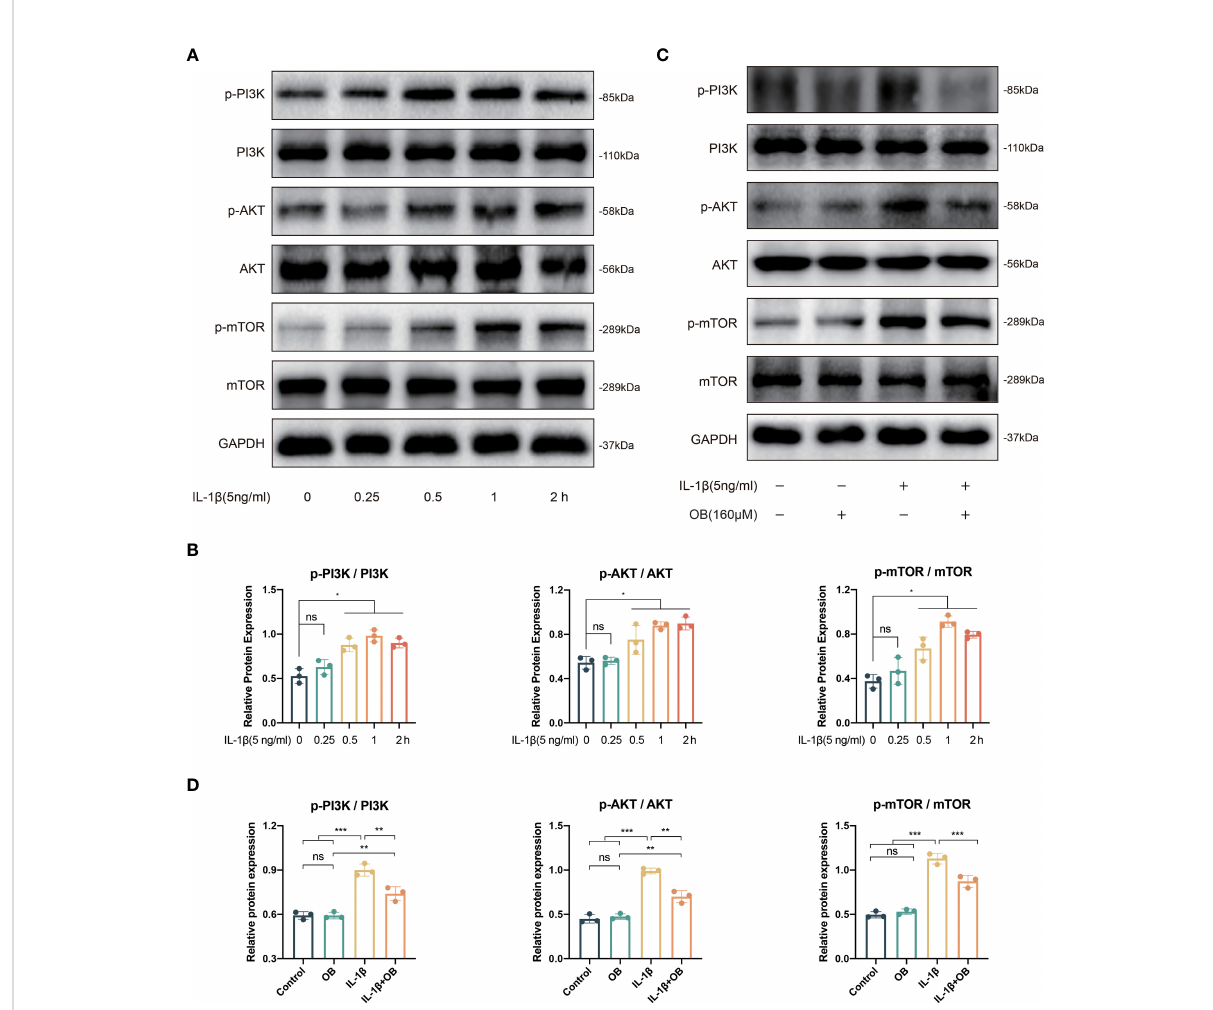
FIGURE 5 IL-1 b triggered the early activation of PI3K/AKT/mTOR signaling pathway and OB inhibited the PI3K/AKT/mTOR signals in IL-1 b – induced chondrocytes. (A) Western blot and (B) quantitative analysis for proteins associated with the PI3K/AKT/mTOR pathway in chondrocytes stimulated with 5 ng/ml IL-1 b at different time durations (0, 0.25, 0.5, 1, and 2h). (C) Western blot analysis and (D) quantitative data the above proteins in chondrocytes which were administered with IL-1 b (5 ng/ml) for 1 h or/and OB (160 m M) for 24 h. Data were presented as means ± SD (n = 3). ns, no signi fi cance; * p < 0.05; ** p < 0.01; *** p <